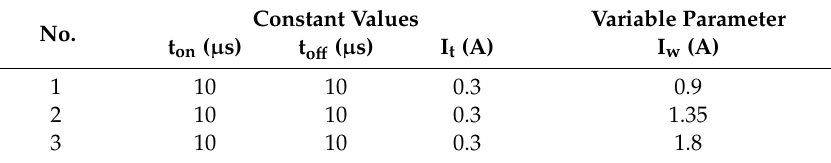
Table 2. The research plan—series one.